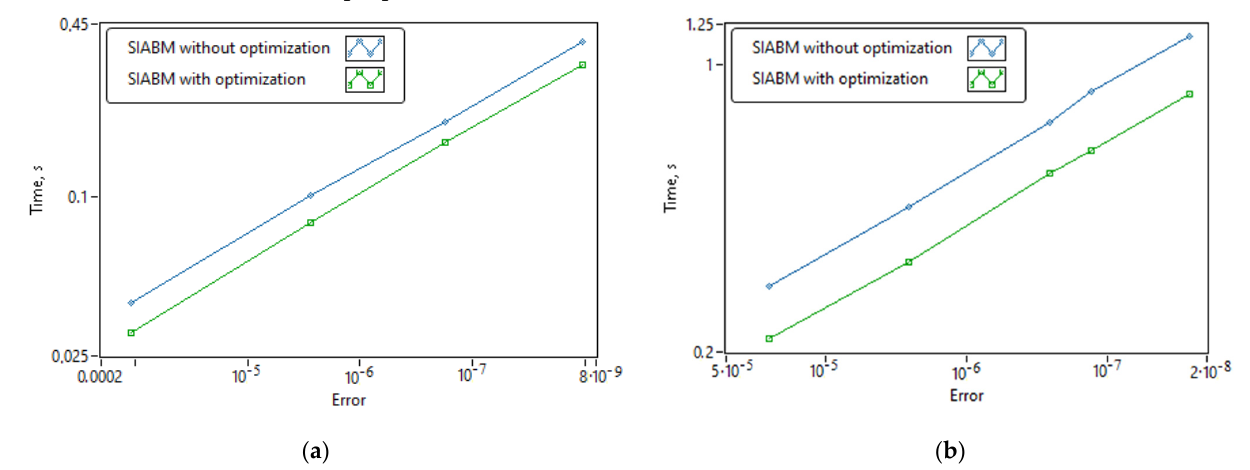
Figure 6. Performance plots for SIABM ODE solvers with and without the proposed optimization technique. ( a ) Fixed integration step; ( b ) variable integration step.